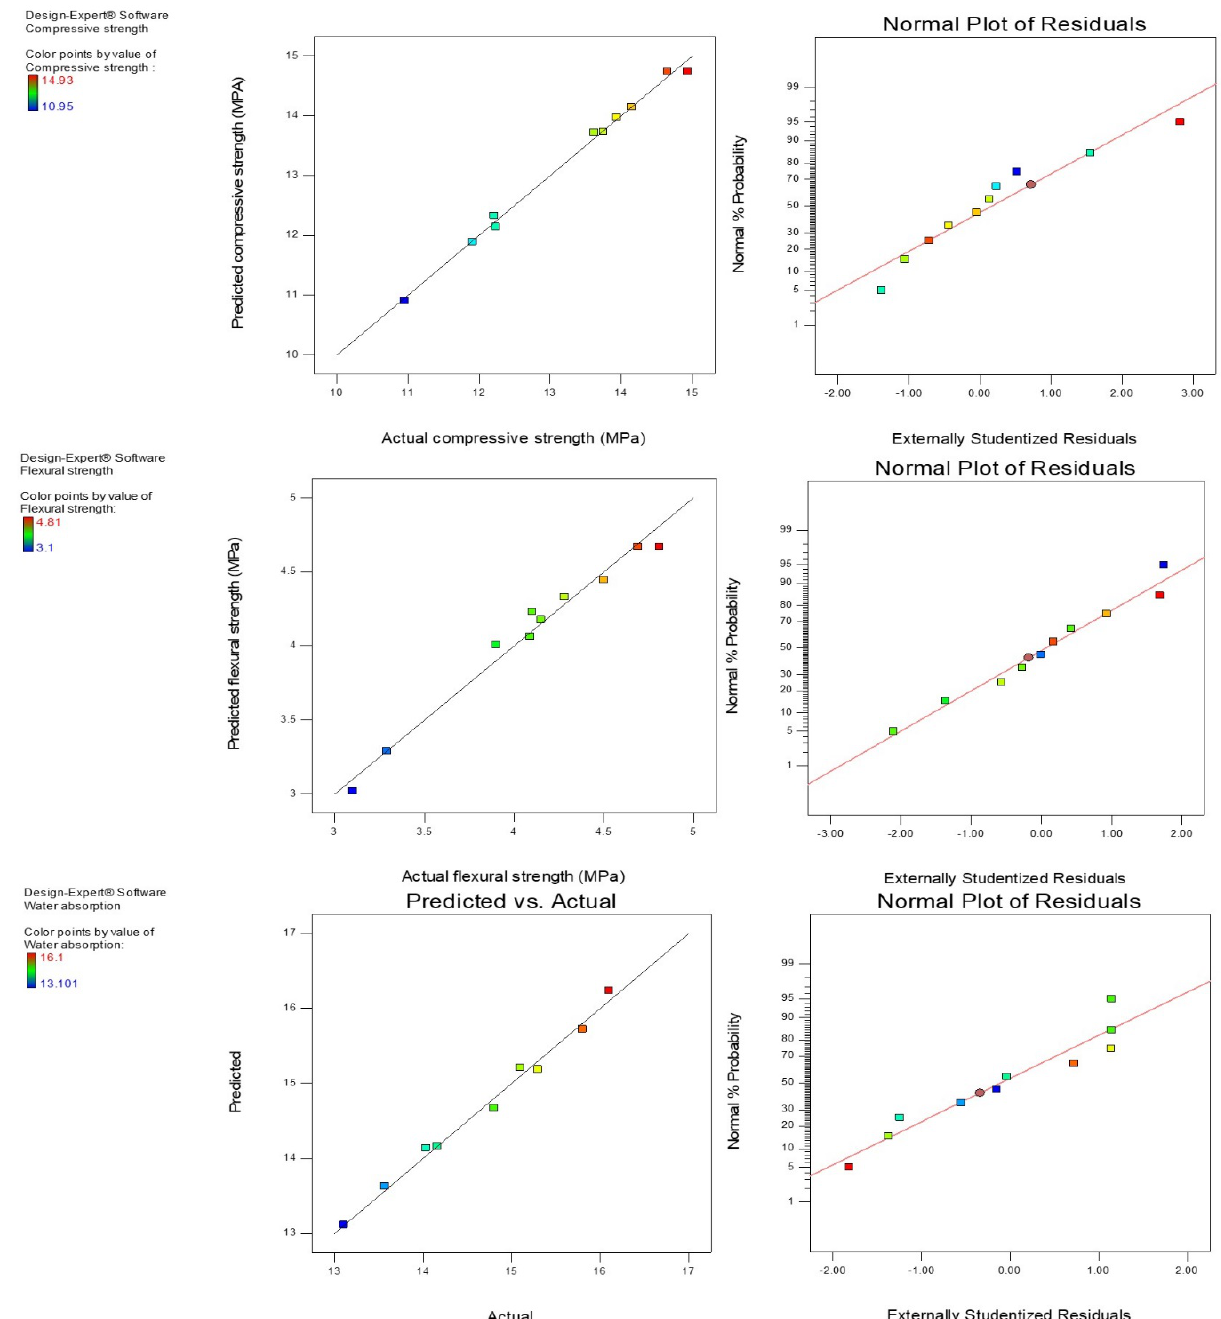
Figure 9. Predicted vs. actual and normal plot of residuals for output variables.